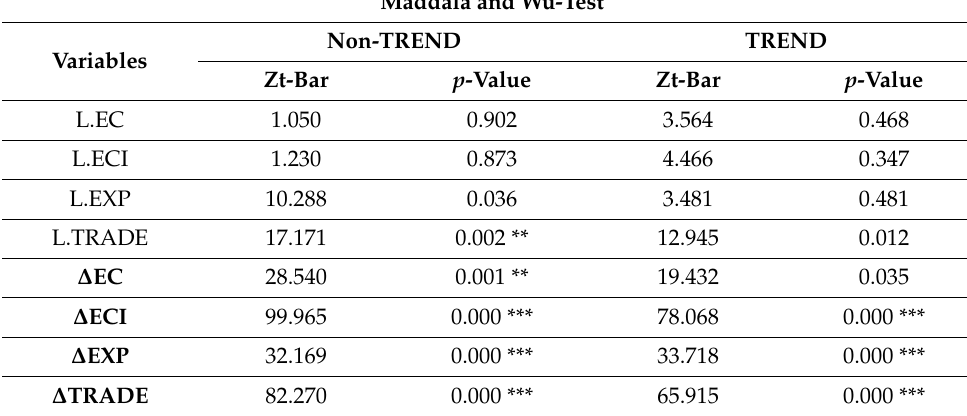
Table 3. Unit root